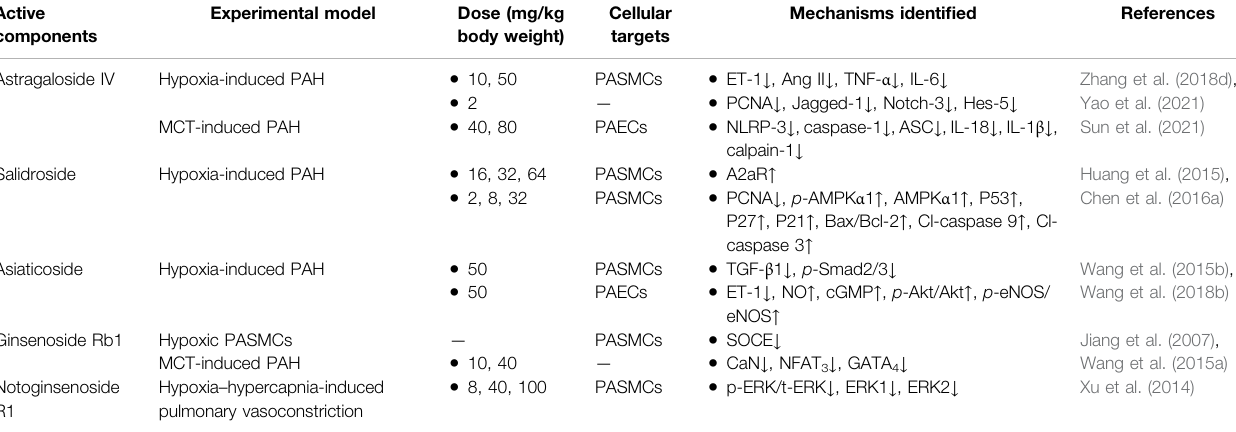
TABLE 6 | Glycosides as THM-derived active components for PAH treatment. Active